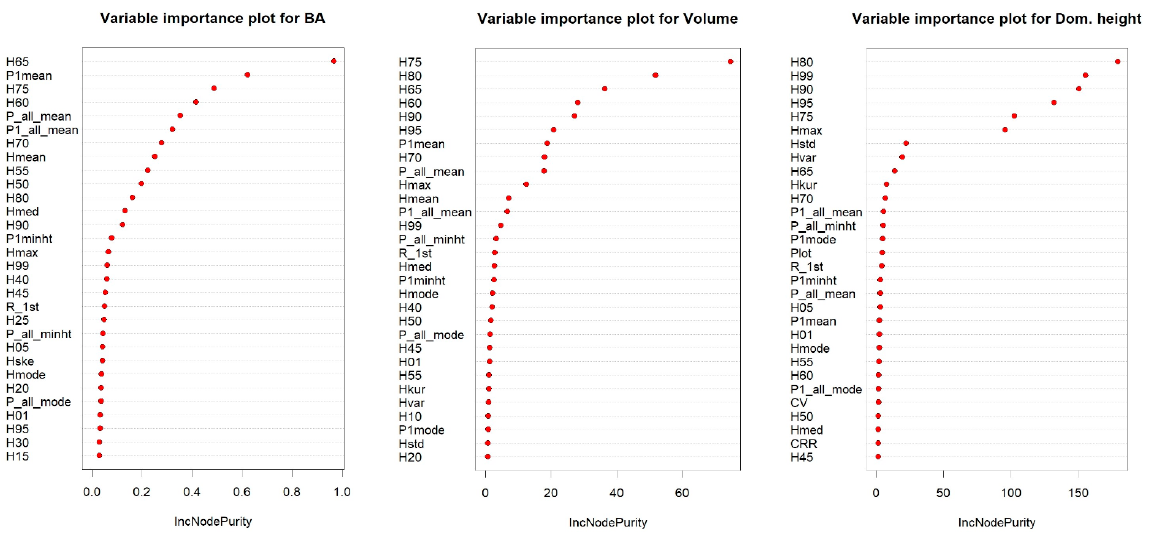
Figure 4. Variable importance plot for dominant height, BA, and volume in random forest models.